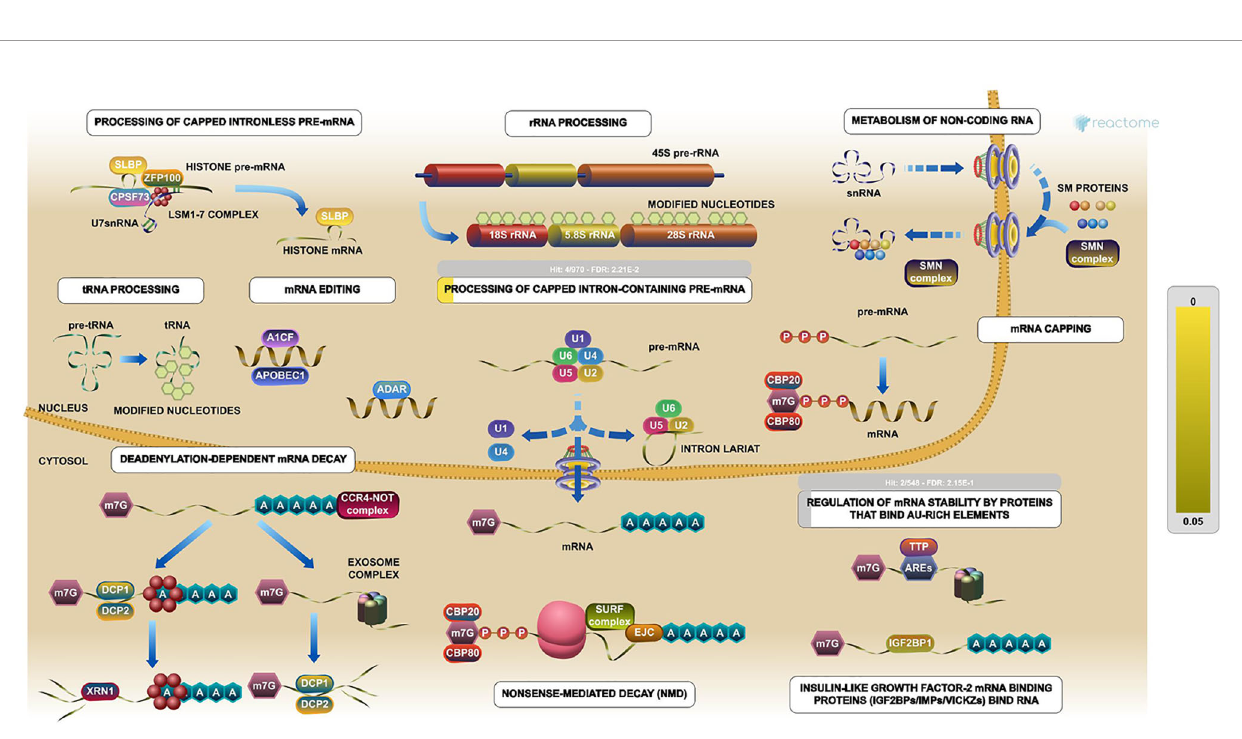
FIGURE 5 | Pathway enrichments of SHGS. PRPF4, SRSF1, HNRNPM, and DHX9 are keys genes in the RNA metabolic pathway. These genes especially are involved in the preprocessing of capped intron-containing pre-mRNA and regulation of mRNA stability by proteins that bind AU-rich elements. (Image extracted from the Reactome pathway